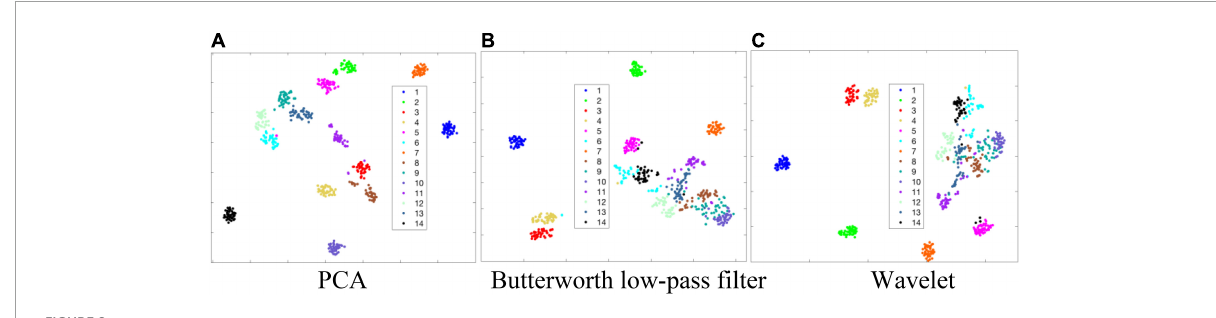
FIGURE8 t-SNE dimensionality reduction feature distributions of gesture signal envelope in the cases of three denoising schemes. (A) PCA. (B) Butterworth low-pass filter. (C) Wavelet.